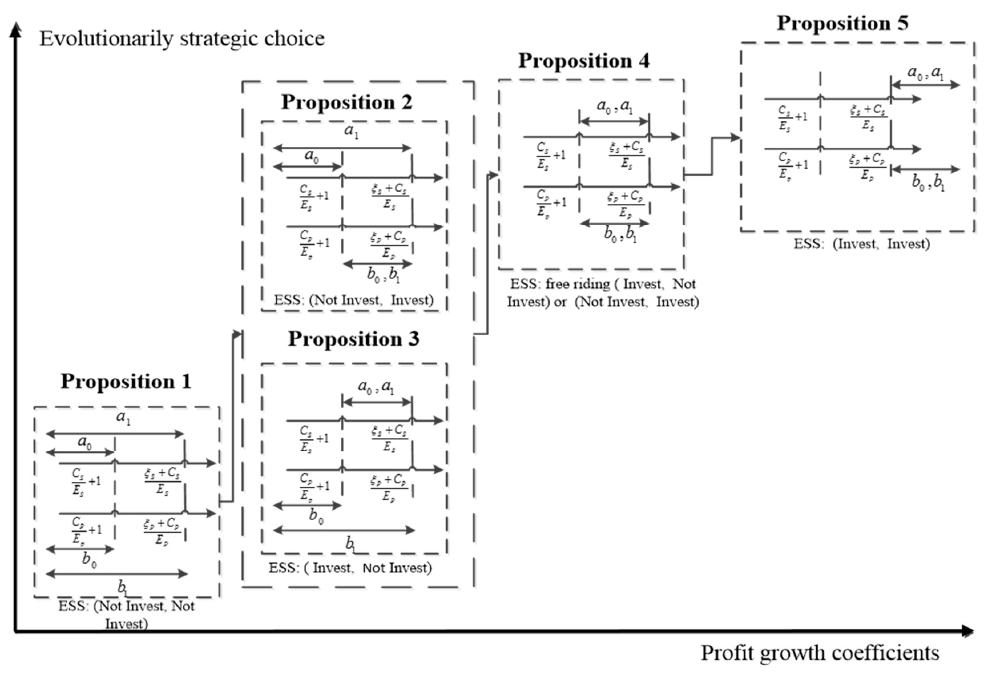
Figure 5. ESS profiles under different intervals of the profit growth coefficients.